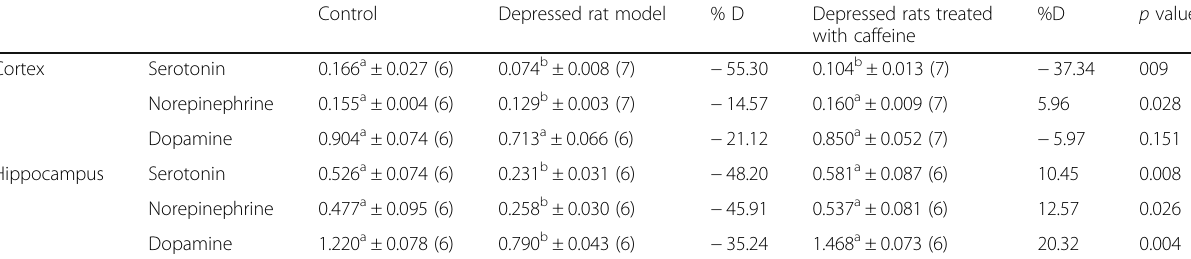
Table 1 Effect of daily caffeine treatment (30 mg/kg) on the level of serotonin ( μ g/g), norepinephrine ( μ g/g), and dopamine ( μ g/g) in the cortex and hippocampus of rat model of depression induced by reserpine